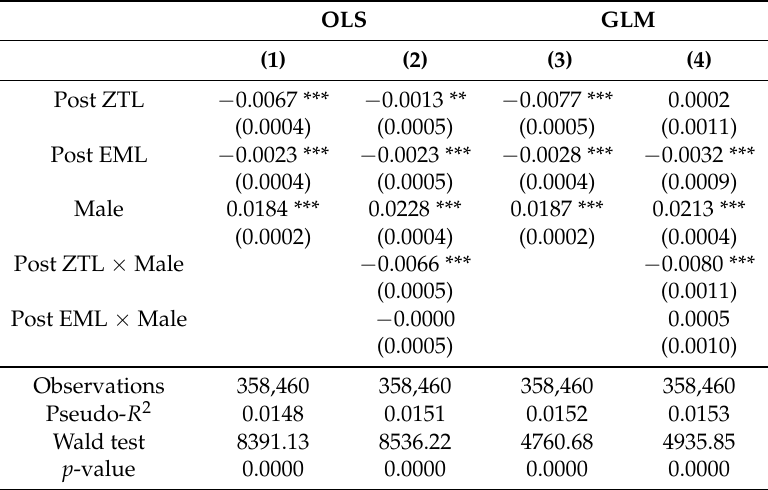
Figure 2. Kernel density plots for blood alcohol content (BAC) tests. For ease of exposition, only 0 < BAC ≤ 0.4 are included. The numbers of observations are 24,255, 17,431 and 22,191 for the no law, ZTL only and ZTL & EML periods, respectively. The Epanechnikov kernel is used, and bandwidth selection follows Silverman [39]. Table 4. Generalized Linear Models: Marginal